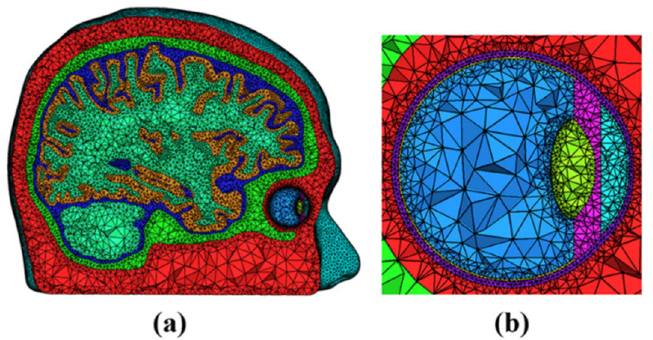
Figure 1. ( a ) Finite element model of the human head—cross-sectional view. ( b ) Enlarged visualization of the segmented human eye composed of tissues: sclera (purple), vitreous body (blue), retina (yellow), lens (green), ciliary body, and iris region (pink), and anterior chamber (sky